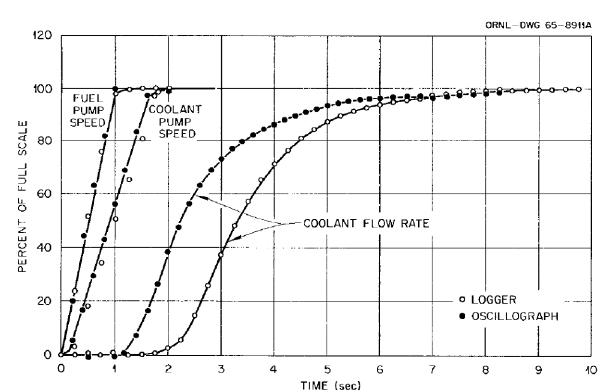
Figure 3. Pump speed variation in the pump startup test